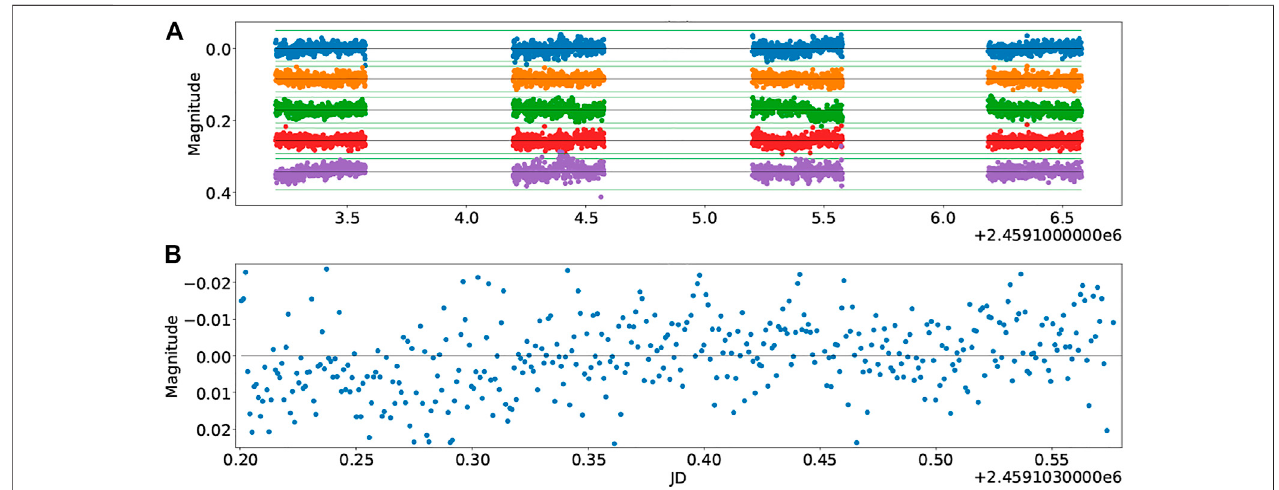
FIGURE 6 | Light curve examples for four stars with m ≈ 15.5 m : (A) for 4 nights, with a ±0.05 m zone shown for each star, and (B) for the fi rst star on the fi rst night.